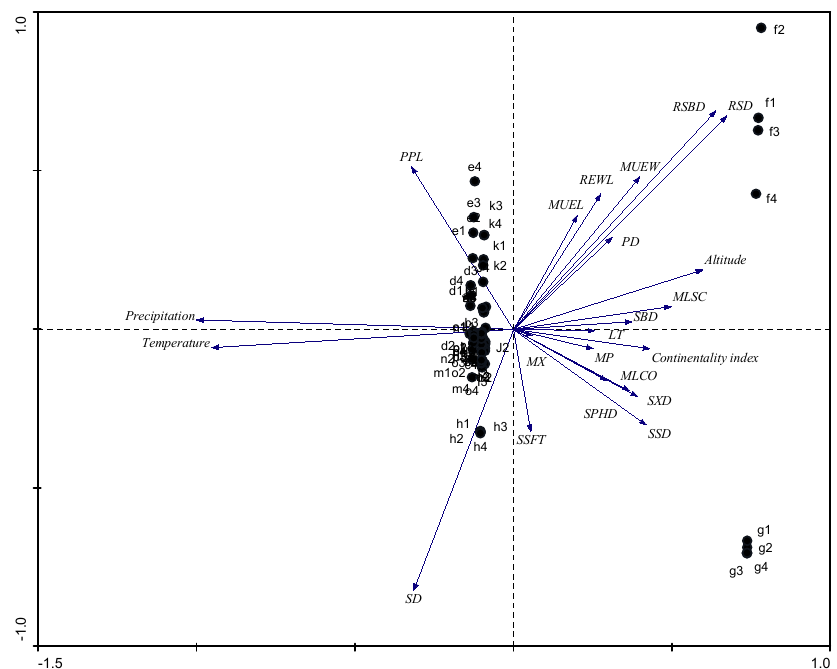
Fig. 5. PCA analysis of 16 populations of Carpinus orientalis: MUEW- Midrib upper epidermis width; MUEL- Midrib upper epidermis length; MLEW- Midrib lower epidermis width; MLCO- Midrib lower collenchyma thickness; MLSC- Midrib lower sclerenchyma thickness; MP- Midrib phloem’s length; LT- Lamina thickness; PPL; Palisade parenchyma length; SSCT- Stem epidermis thickness; SSFT- Stem sclerenchymal fiber thickness; SPHD- Stem phloem diameter; SXD- Stem xylem diameter; SSD- Stem stele diameter; SD- Stem diameter; RSD- SSD / SD; RSBD- SBD / SD; RSPH- SPHL / SSD; PD- Petiole diameter